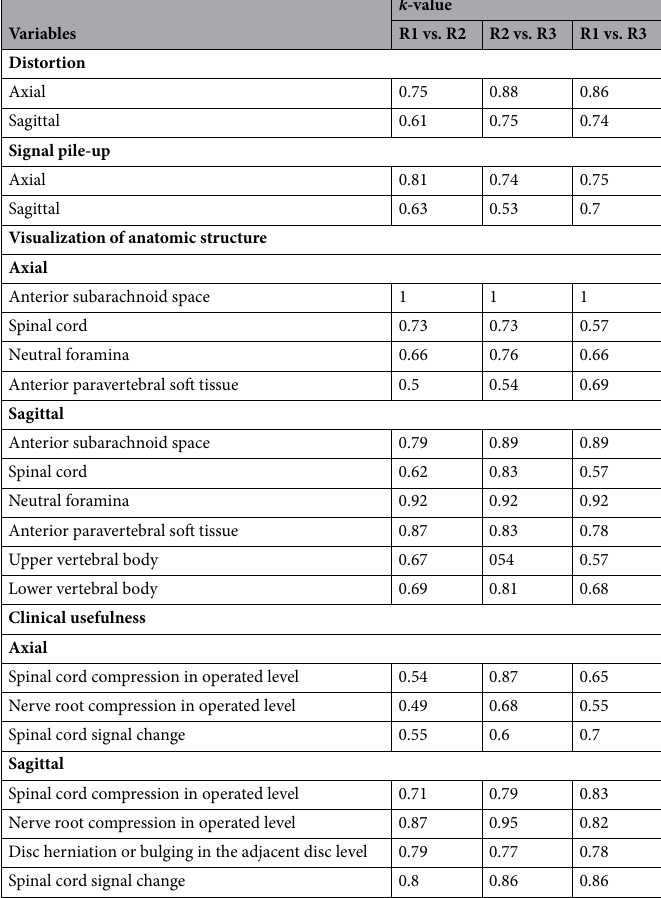
Table 2. The k values of interobserver agreement for the qualitative analysis. R1 reader 1, R2 reader 2, R3 reader 3.